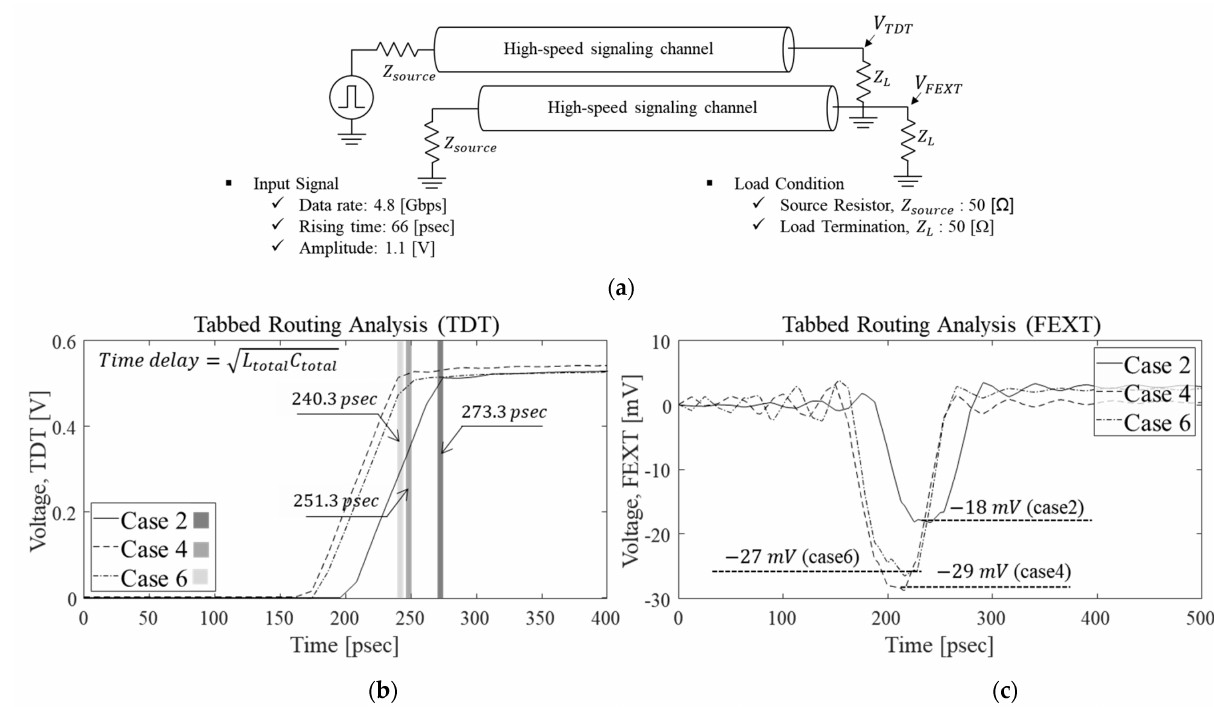
Figure 11. ( a ) Time domain simulation set-up. To evaluate SI in the time domain, the simulation parameters, including the rising time and amplitude suitable for the 4.8 Gbps target, were set. Using this set-up, SI analysis is conducted for ( b ) TDT, and ( c ) FEXT for the comparison of cases 2, 4, and